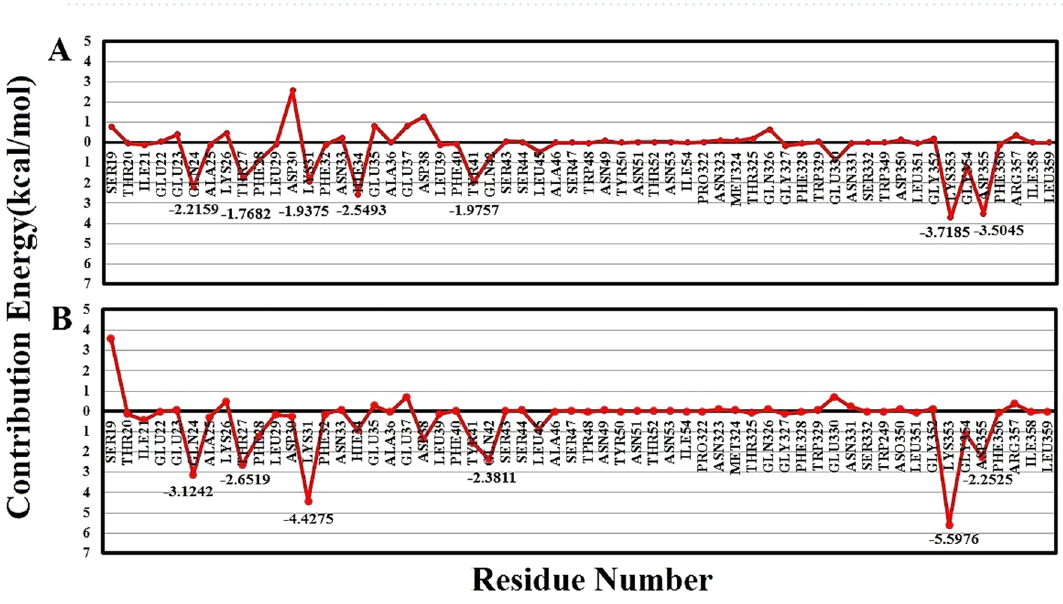
Figure 5. Free energy decomposition of the ACE2 residues in the spike-ACE2 complex: ( A ) SARS-COV and ( B ) SARS-COV-2. The red graph shows binding free energy for each residue in ACE2